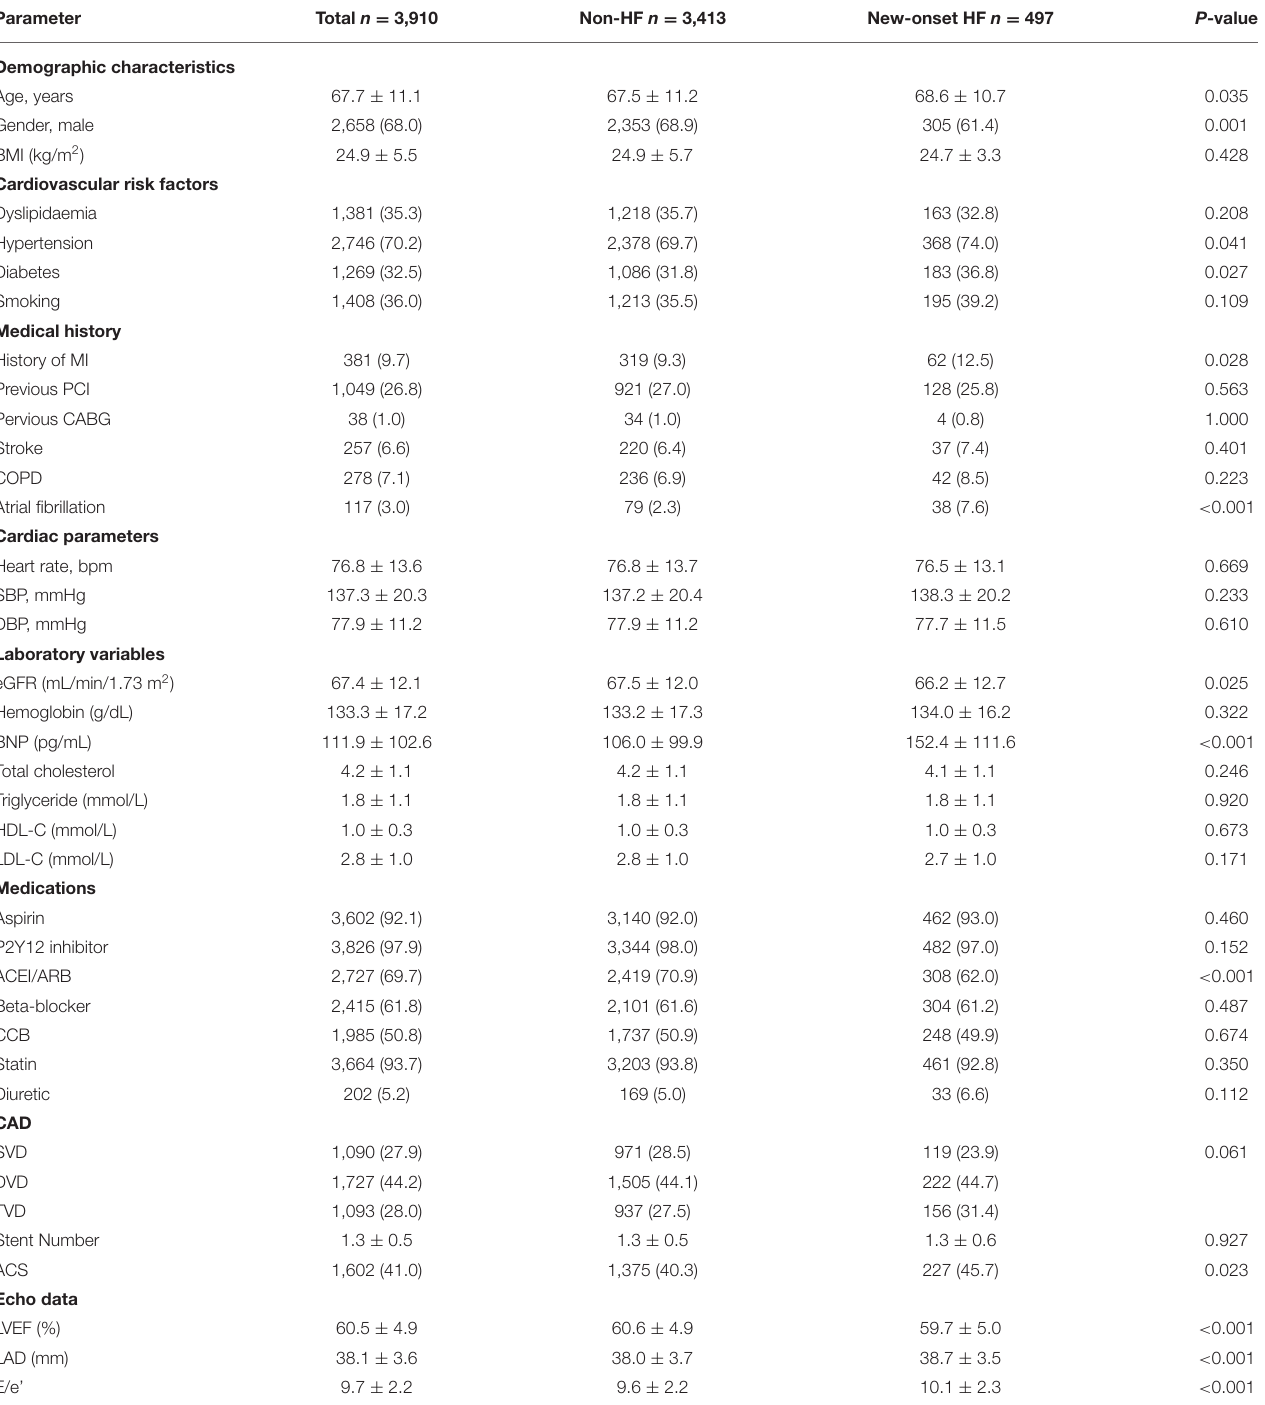
TABLE 1 | Baseline clinical characteristics and medications.